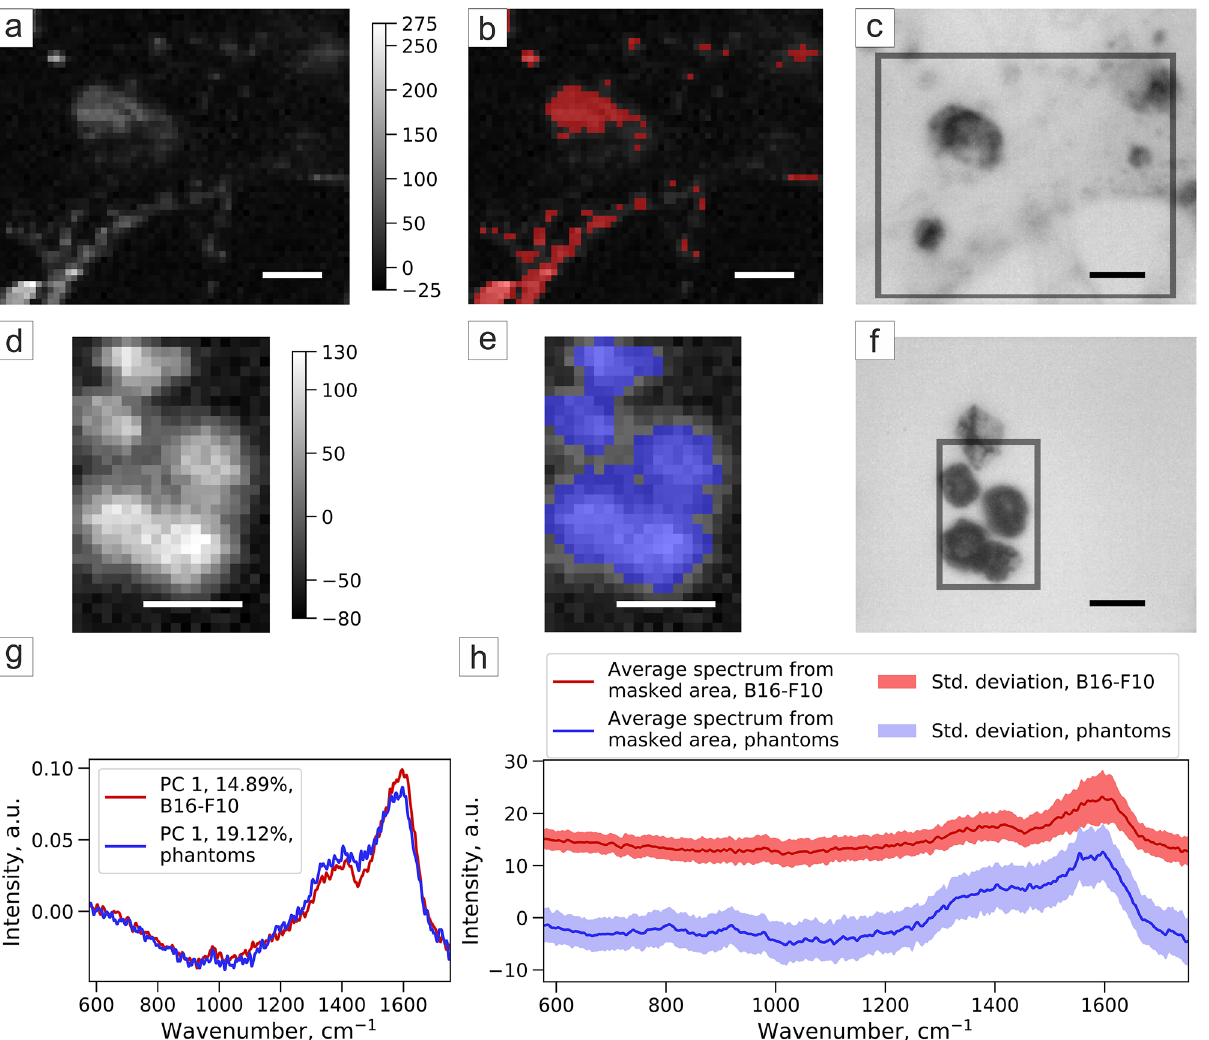
Figure 8. Principal component analysis of Raman spectroscopy of ( a – c ) B16F10 and ( d – f ) melanoma phantoms: ( a , d ) map of PCA component corresponding to melanin; ( b , e ) melanin-rich area selected by Otsu thresholding of PCA component map; ( c , f ) brightfield image, grey frame shows the scanning area; ( g ) Raman spectra of the component in PCA corresponding to melanin and ( h ) average Raman spectra with a standard deviation of masked areas of B16F10 and melanoma phantom